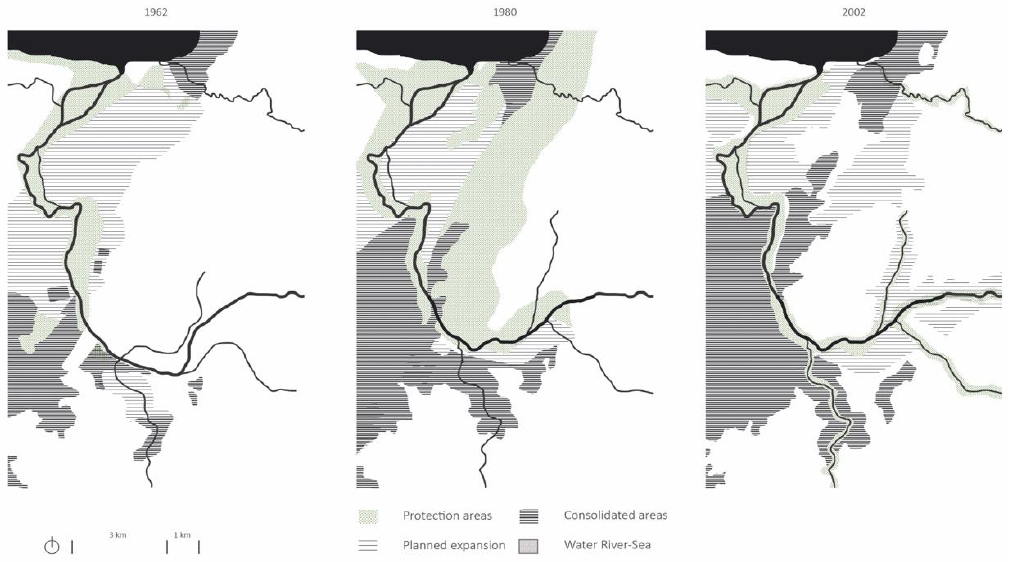
Figure 2. Concepción Metropolitan Regulatory Plans Comparative (PRMC) 1962, 1980, 2002 in the study area. Evolution of protected versus urbanization area. Source: By the author Espinosa, modified from [55].